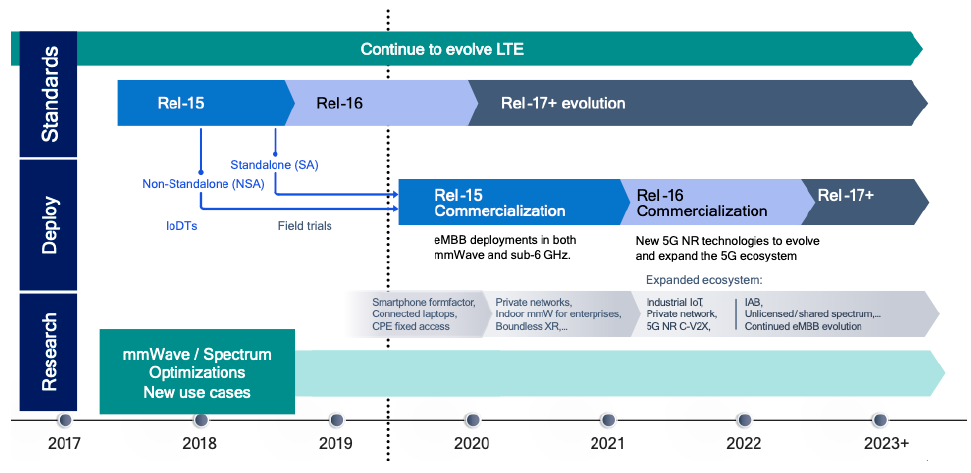
Figure 2. 5G Roadmap of IMT 2020 [12].